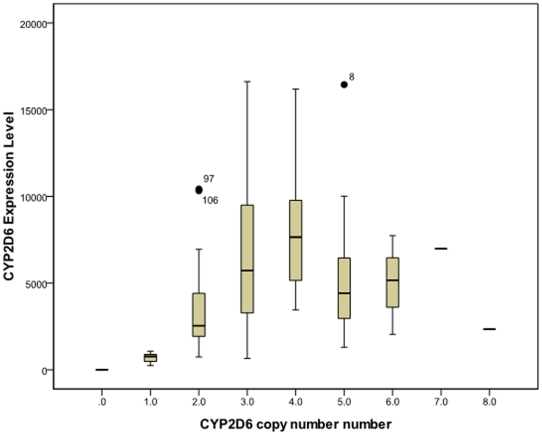
Relationship between copy number and the mRNA level of CYP2D6.Both deletion and multiple duplications of CYP2D6 were observed in the 96 samples. One, seven and fourteen samples were identified as 0, 1 and ≧5 copies of CYP2D6, respectively. Increasing copy numbers tended to increase the expression level for samples with <5 copies but not for those with ≧5 copies.